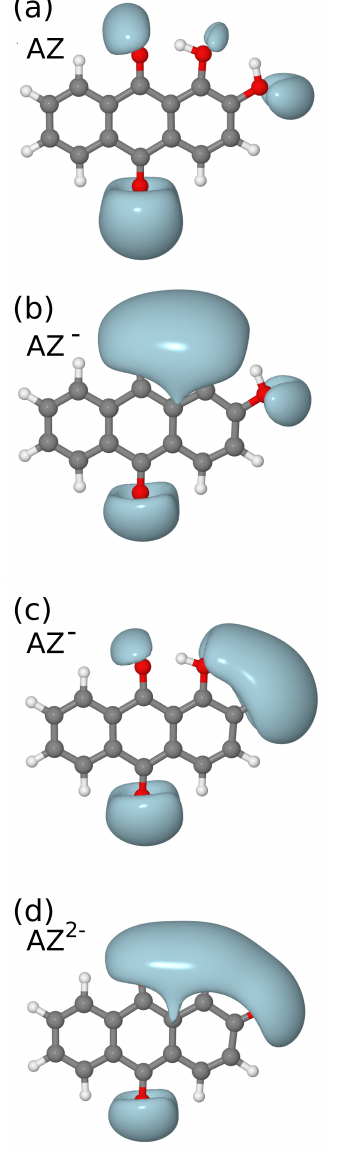
Figure 2. Electrostatic potential for: ( a ) AZ; ( b ) AZ − with deprotonation on oxygen atom bound to C1; ( c ) AZ − with deprotonation on oxygen atom bound to C2; and ( d ) AZ 2 − . The C1 and C2 atom labels are reported in Figure